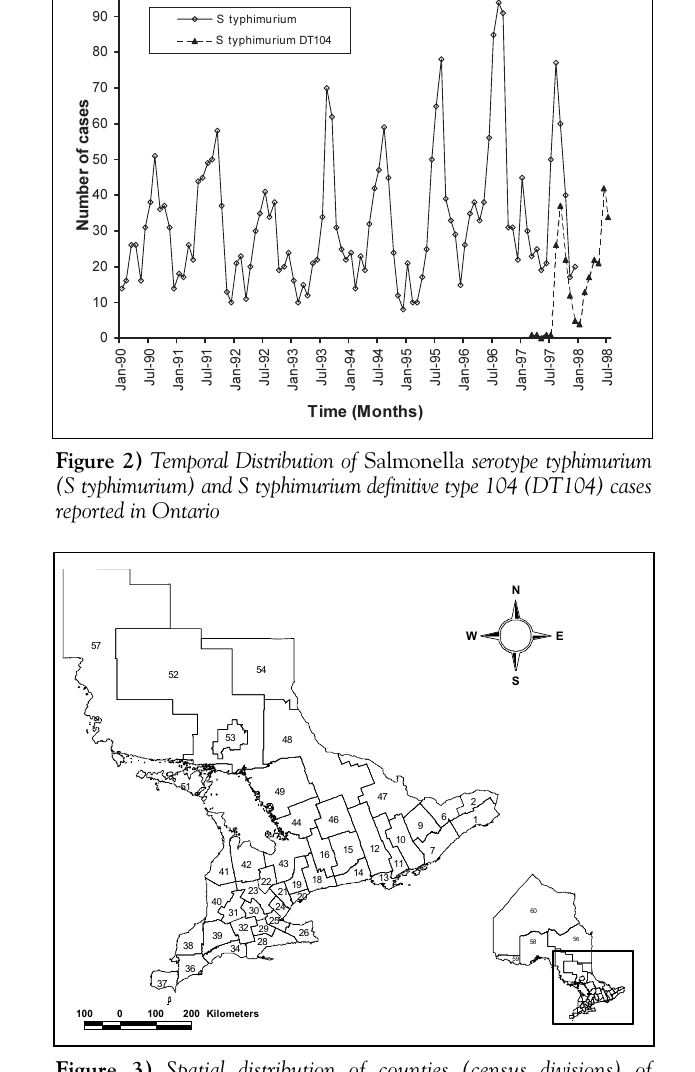
Figure 3) Spatial distribution of counties (census divisions) of Ontario. Please see Appendix I for a legend of this